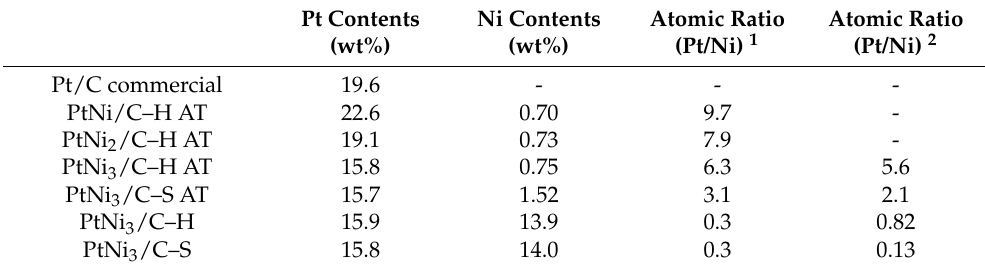
Table 1. Metal content of the catalyst measured by ICP-OES.